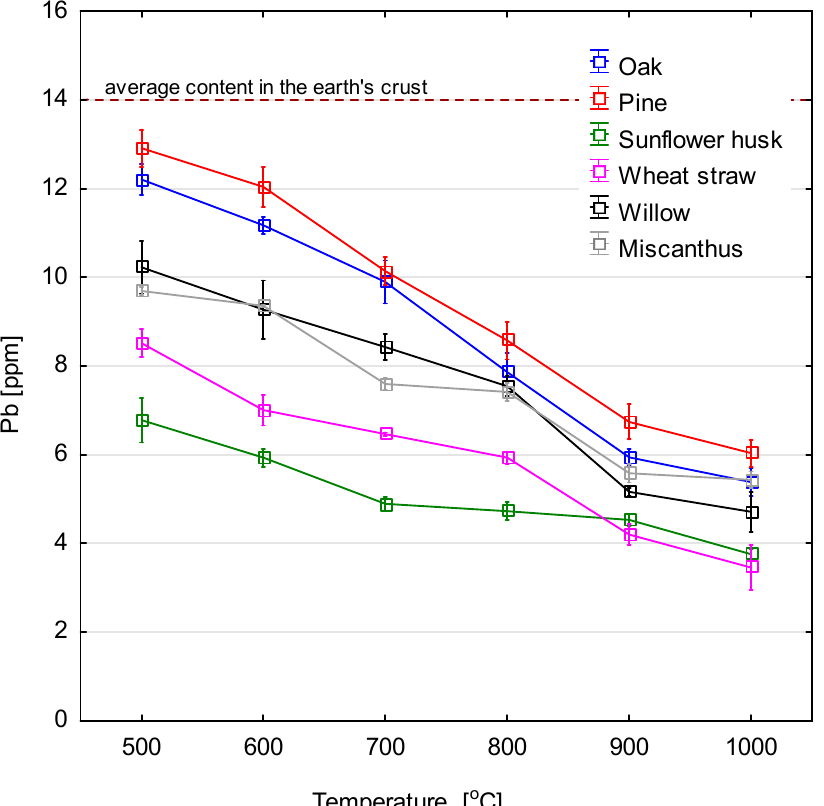
Figure 7. Changes in Pb content in the examined biomass depending on ash-forming temperature.